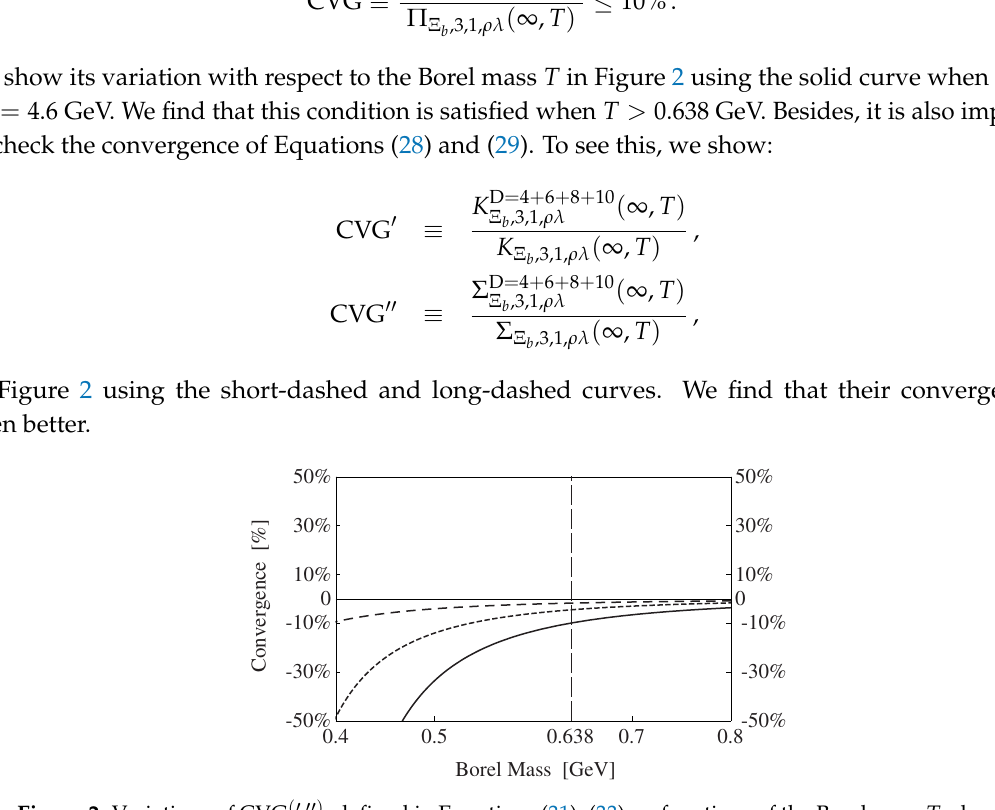
Figure 2. Variations of CVG ( (cid:48) , (cid:48)(cid:48) ) , defined in Equations (31)–(33), as functions of the Borel mass T , shown as the solid, short-dashed and long-dashed curves,